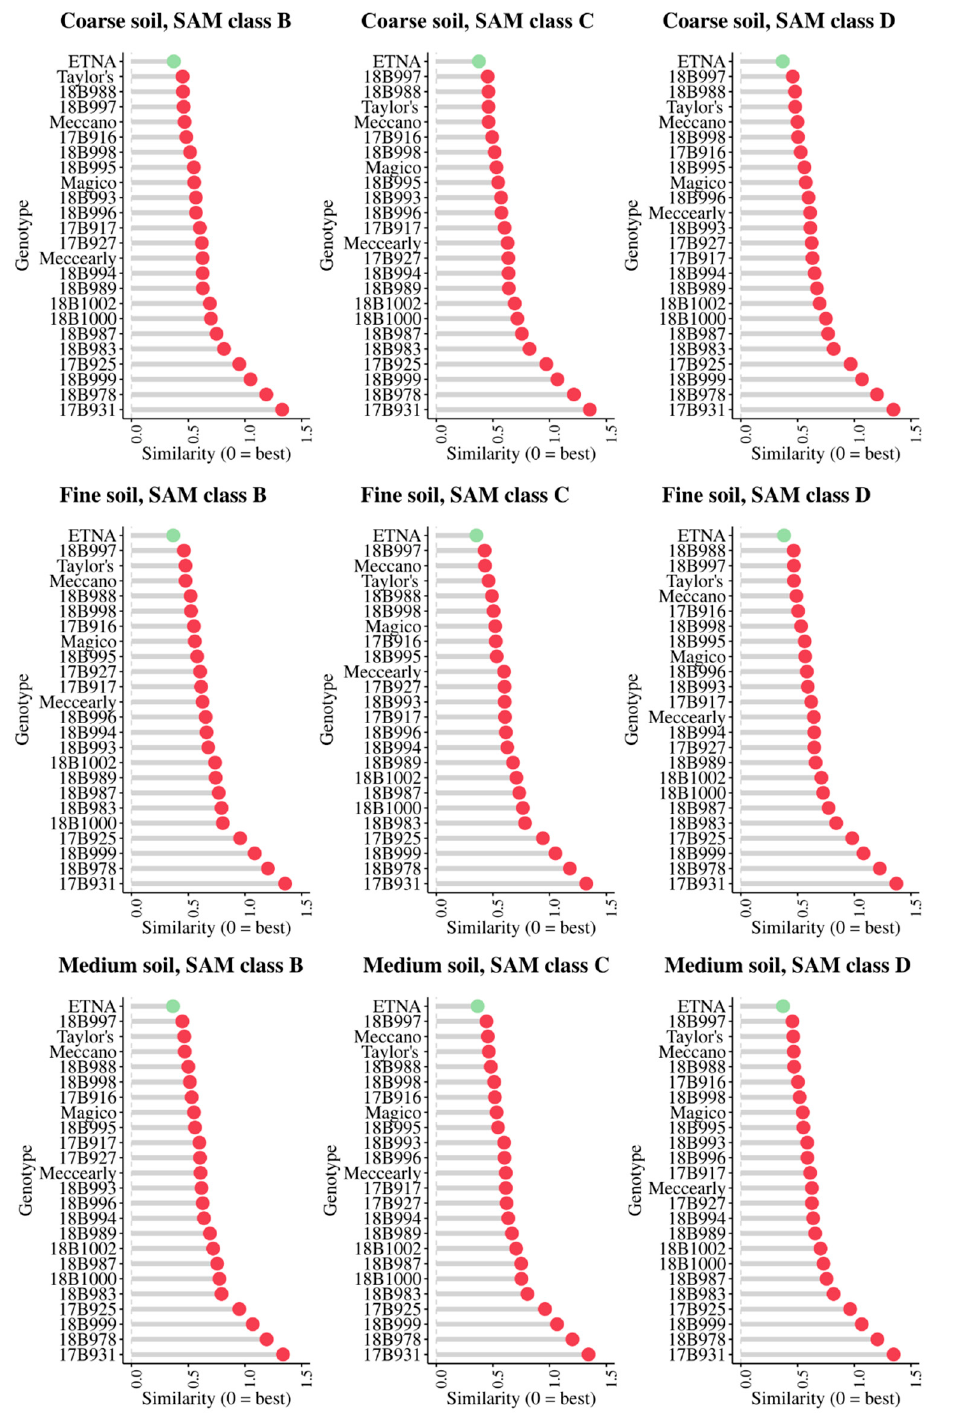
Figure 5. Similarity indices for early sowings between the ideotypes defined for the di ff erent agro-climatic contexts and the functional trait profiles of the 24 varieties analyzed in this study. Green dots: varieties recommendable (di ff erence in similarity index lower than 10% compared to the most similar to the ideotype); red dots: varieties less suitable (di ff erence in similarity index larger than 20%).